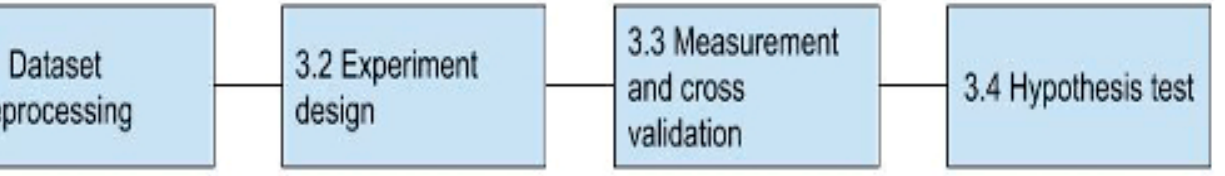
Figure 4. Block diagram of the proposed solution approach.